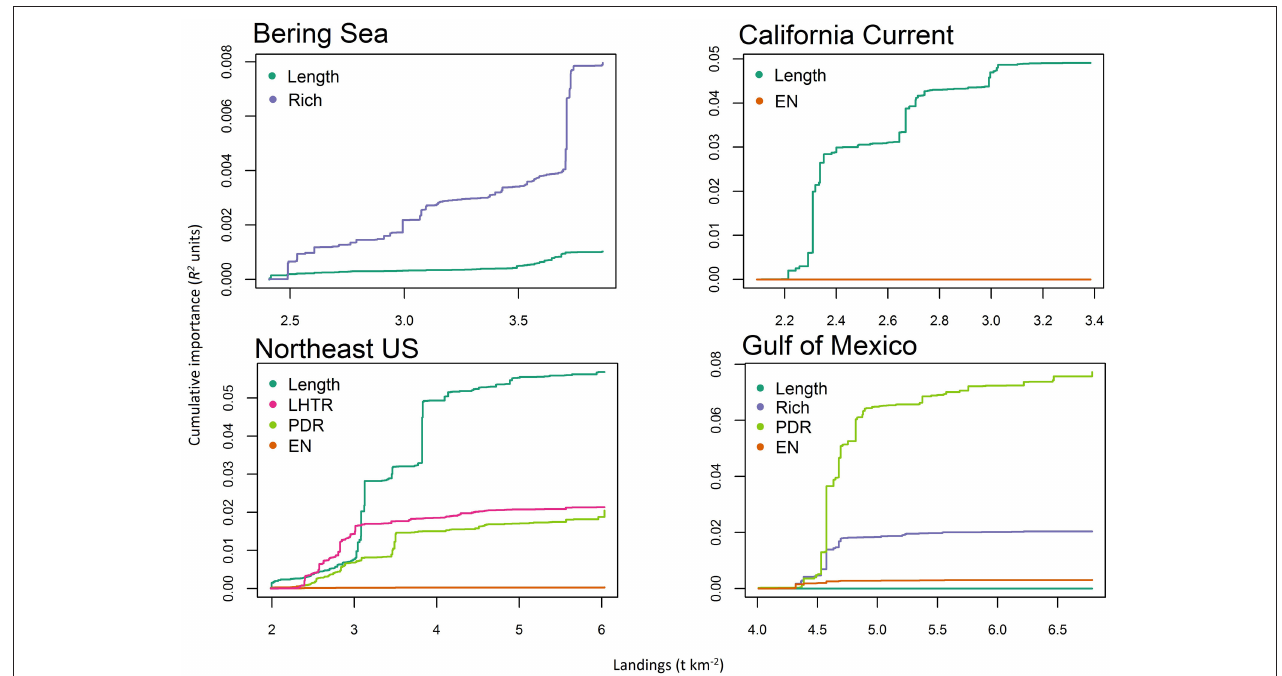
FIGURE 4 | Cumulative shifts (in R 2 units) of ecological indicator value in response to landings (t km − 2 ) from the gradient forest analyses for Alaska (Bering Sea), California Current, Northeast US, and Gulf of Mexico. Thresholds are defined as a steep increase in ecological indicator response to a pressure. Ecological indicators are mean length of catch (Length), species richness (Rich), pelagic to demersal ratio (PDR), low to high trophic ratio (LHTR), species diversity